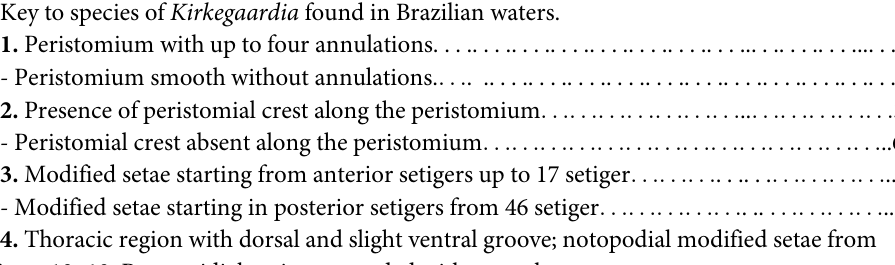
groove (Fig 12E). Pygidium with a conical ventral lobe (Fig